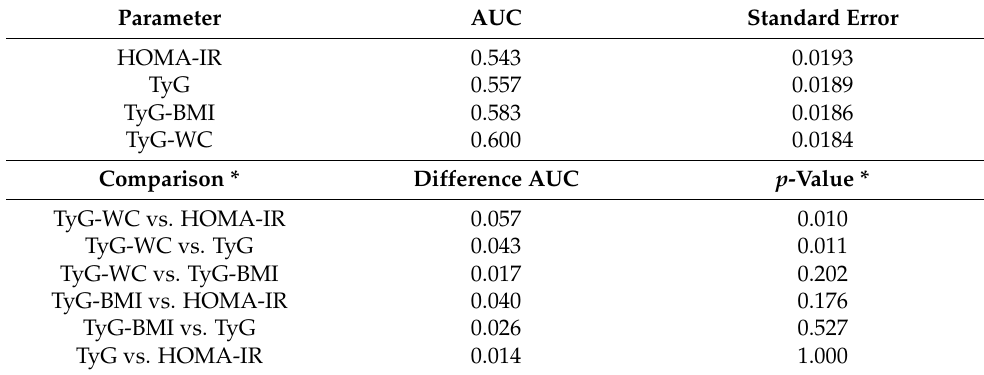
Table 3. Areas under the receiver operating characteristic curves of each parameter for CAC progres- sion in the final cohort including non-progressors and progressors ( n =